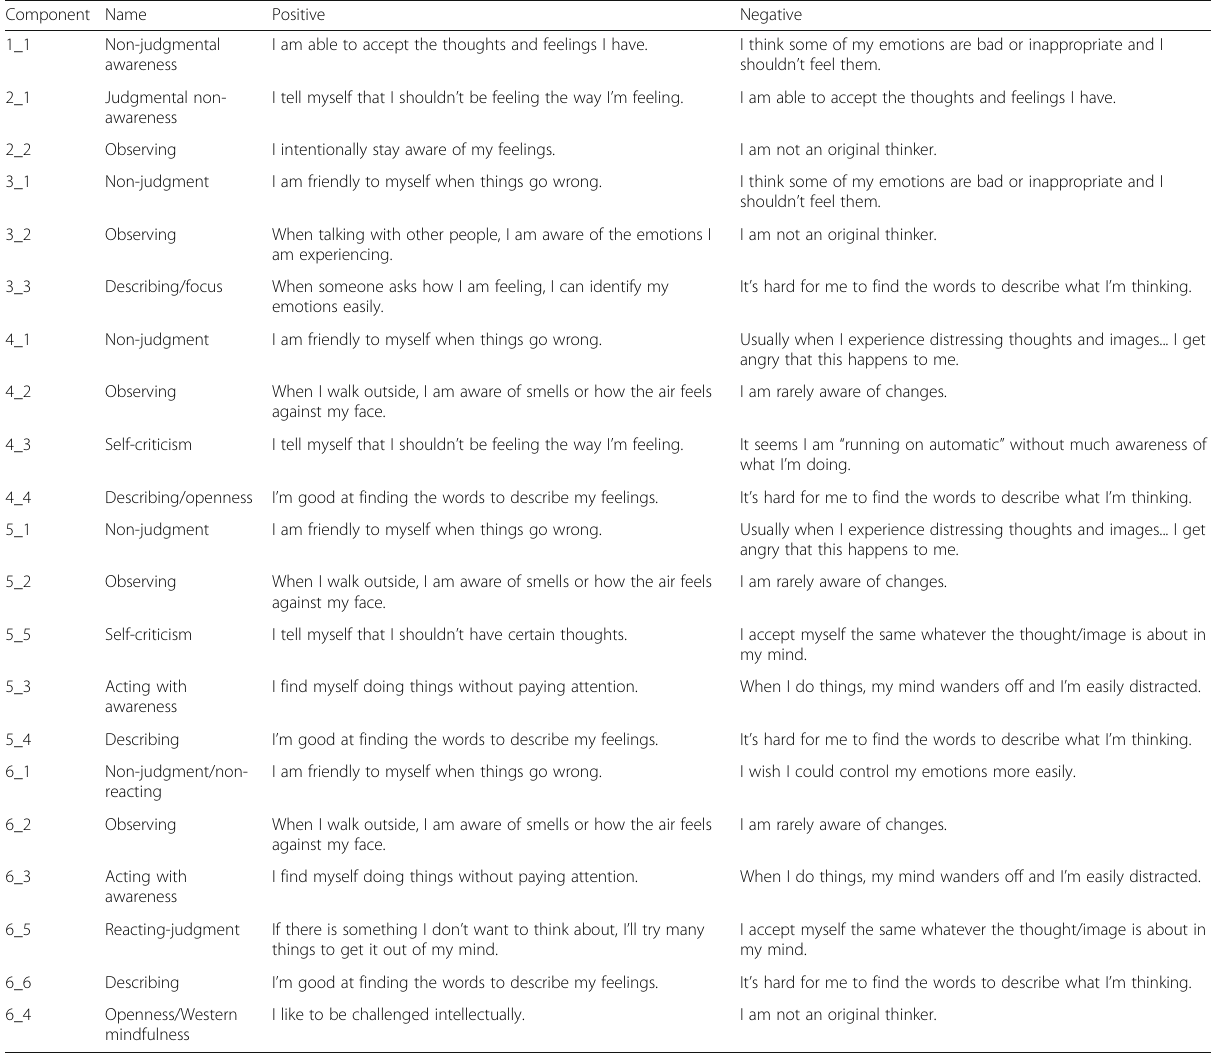
Table 3 Components extracted with their highest positive and negative loading